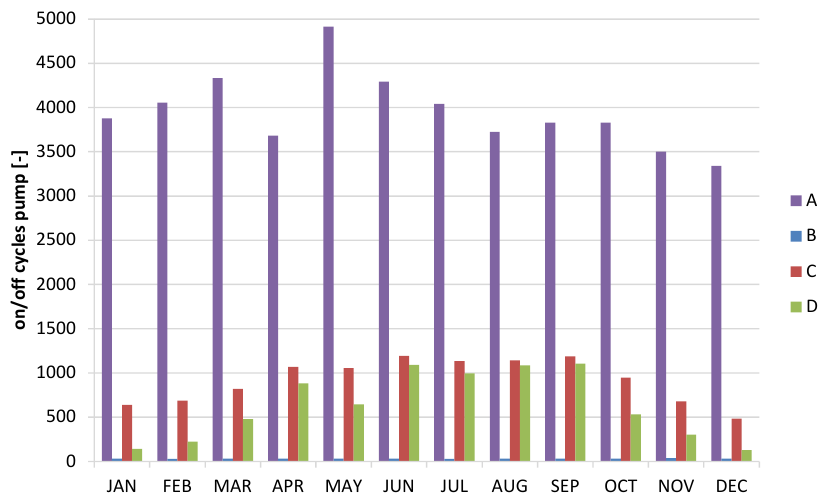
/ o ff cycles between the four di ff erent control Figure 7. Monthly profile of the solar pump on/off cycles between the four different control strategies. Figure 7. Monthly profile of the solar pump on